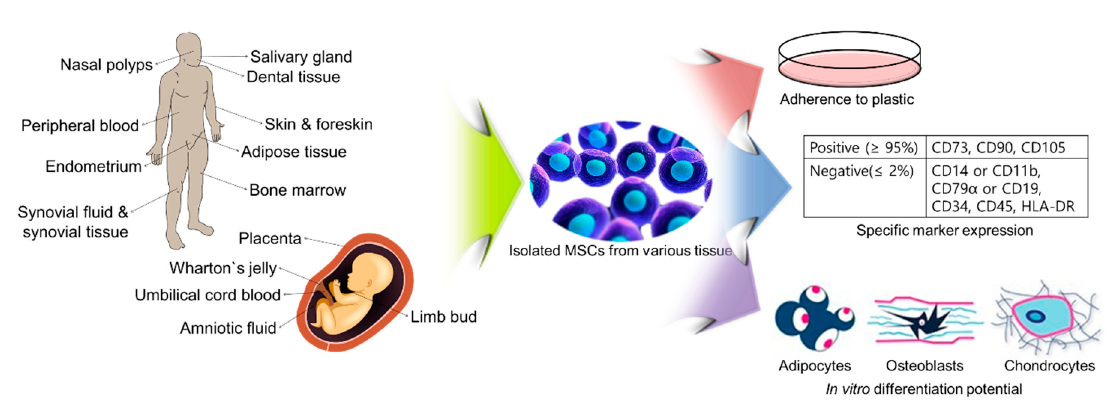
Figure 1. Characteristics and source of isolation of human mesenchymal stem cells (hMSCs).